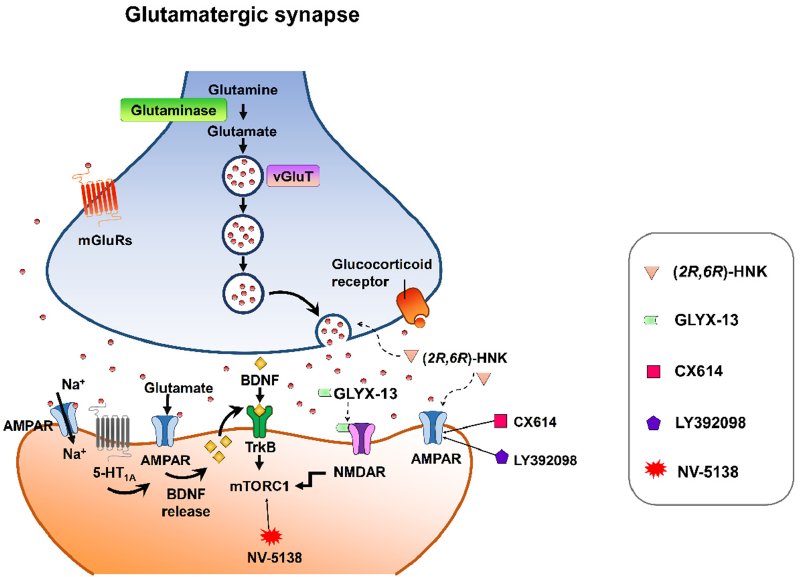
Figure 3. Synaptic model for the cellular target sites for different types of candidate drugs for antidepressants. ( 2R,6R )-HNK exerts increased glutamate release and AMPA receptor-mediated synaptic potentiation. GLYX-13 elicited partial activation of the NMDA receptor, hence activation of mTORC1 and thus induction of protein synthesis. CX614 and LY392098, AMPA receptor potentiators, induce antidepressant effects by enhancement of AMPA receptor function and BDNF expression. NV-5138 exerts rapid and sustained antidepressant effects through stimulating mTORC1 signaling. Activation of the 5-HT 1A receptor produces rapid and sustained antidepressant effects through the initiation of AMPA receptor/BDNF/mTORC1 cascades. All the candidates propose long-lasting modifications in synaptic plasticity, resulting in strengthening of glutamatergic synapses, which is necessary for antidepressant responses. 5. Conclusions Chronic stress elicits intricate functional and structural alterations in various brain regions. With regard to the glutamatergic synapse, chronic stress is known to either strengthen or weaken effects that are associated with improved or impaired function, respectively, and this change may contribute to the pathophysiology of neuropsychiatric disorders. Mounting evidence reveals the critical role of homeostatic control of synaptic connections in mood-associated circuits in the etiology and treatment of depression. Further research is required to explore the effects of chronic stress and antidepressants on different brain areas and the mood-related neural circuits and to unmask the functional importance of synaptic maladaptation on behavior changes. These preclinical studies will further determine the neuronal and synaptic changes underlying depression and will contribute to the development of more efficacious, rapid-acting, sustained, and safer antidepressants. Although there is still enormous undiscovered neural maladaptation in the diseased brain, to date, these results reveal insight into the pathogenesis of depression and provide a novel strategy for refining therapeutic approaches to depressive disorders. Author Contributions: Conceptualization, Y.-C.H.; resources, M.T.L. and Y.-C.H.; writing — original draft preparation, M.T.L. and Y.-C.H.; writing — review and editing, M.T.L., W.-H.P., H.- W.K., C.-C.W., D.-W.W. and Y.-C.H.; visualization, Y.-C.H.; supervision, Y.-C.H. project administration, W.-H.P., H.-W.K., C.-C.W., M.T.L., and Y.-C.H.; funding acquisition, W.-H.P., H.- W.K., C.-C.W., M.T.L. and Y.-C.H.. All authors have read and agreed to the published version of the manuscript.